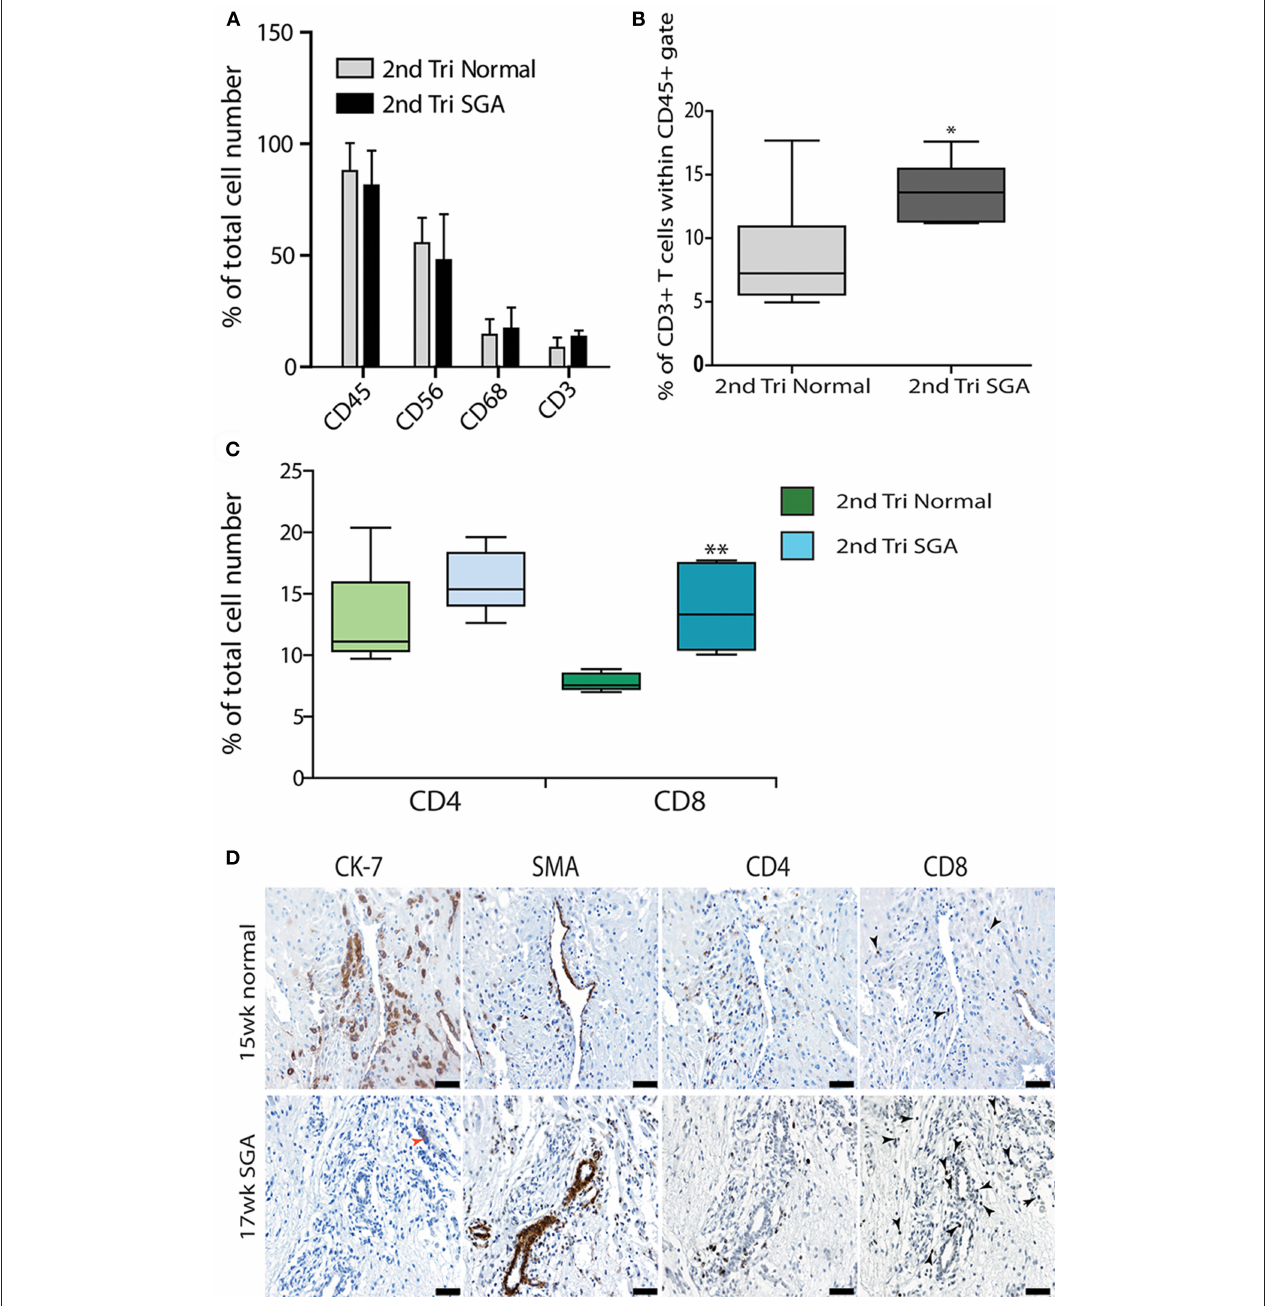
FIGURE 6 | Elevated cytotoxic CD8 + T cells in 2nd trimester high Uterine artery PI and SGA decidua. Multicolored flow cytometry analysis of leukocyte subsets isolated from 2nd trimester normal or high uterine artery PI ( > 1.6) of decidua. Numbers of CD45 + leukocytes, CD56 ++ uNK, and CD68 + macrophage were no different between groups (A) . CD3 + T cells gated within the CD45 + population were doubled in the high uterine artery PI decidua (B) . Visiopharm Newcast image analysis system and random meander sampling was used to quantify numbers of CD4 + T cells and CD8 + T cells in 5% of the total tissue area of each decidual section. Percentages of the total cell number were calculated and are presented as box whisker plots in (C) . Representative serial sections from a 15-week normal sample (upper panel) and a 17-week high uterine artery PI SGA) stained with CK7, SMA CD4 and CD8 antibodies are shown in (D) (arrows identify CD8 + T cells). * p < 0.05, ** p < 0.01, n = 6 in each group. Scale bars = 20 µ M, 200x magnification. lower in IUGR, while mature CD83 + dendritic and CD3 + T a failure of both interstitial and endovascular invasion into the cells were found in clusters in association with apoptotic EVT decidual myometrial junction, and high numbers of apoptotic in the myometrial portions of these vessels. In the 2nd trimester mural and interstitial EVT. Numbers of decidual leukocytes were